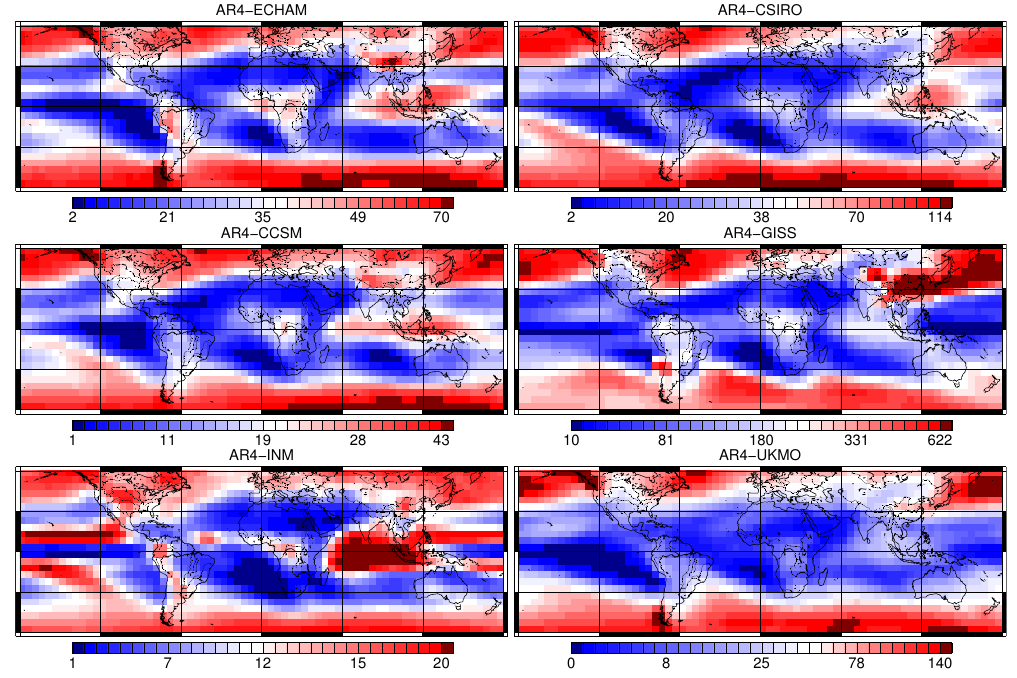
Fig. 6. Same as Fig. 5, except for model data, and all available monthly IWP data are used.